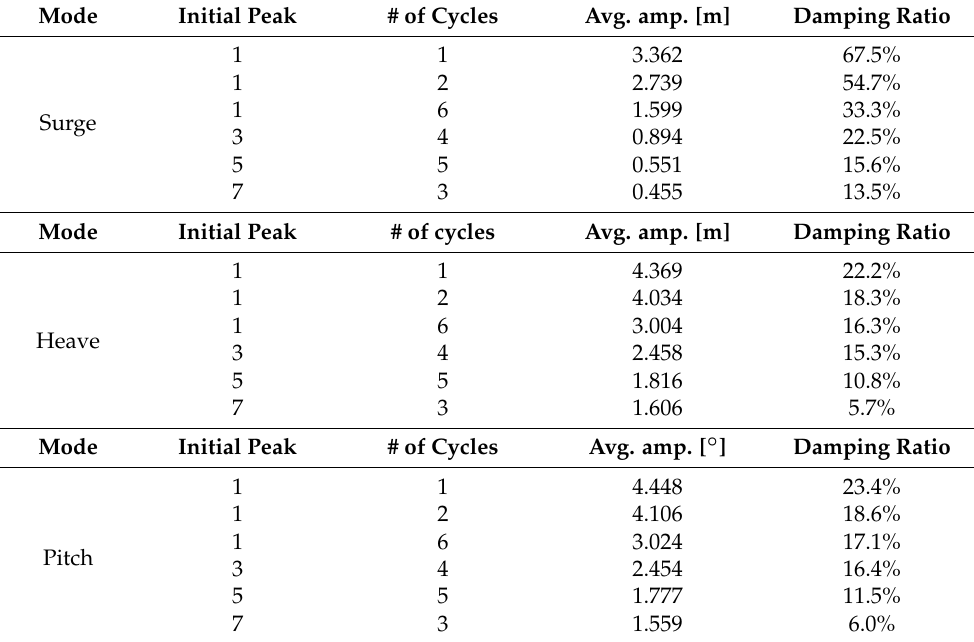
Table 4. Damping ratios obtained from experimental free decay